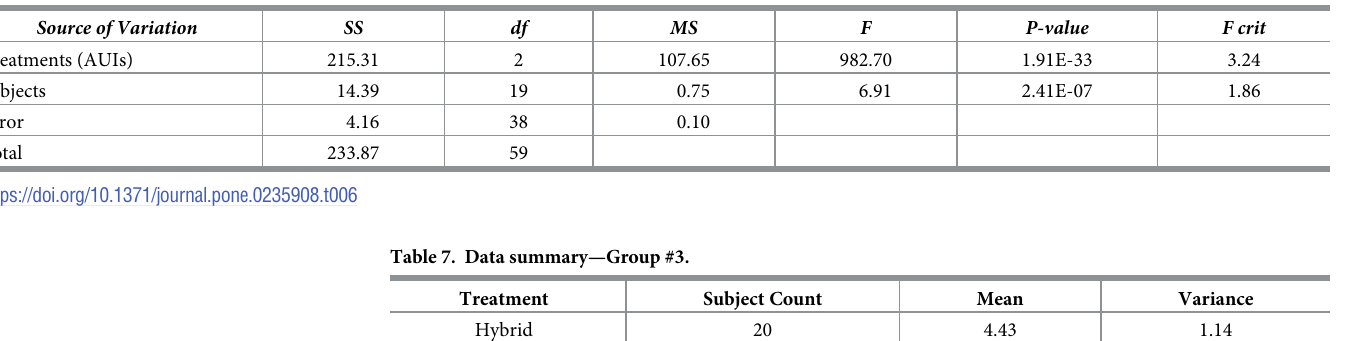
Table 6. Repeated-measures ANOVA—Group #2.